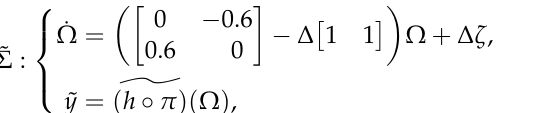
Figure 7. Approximated moment